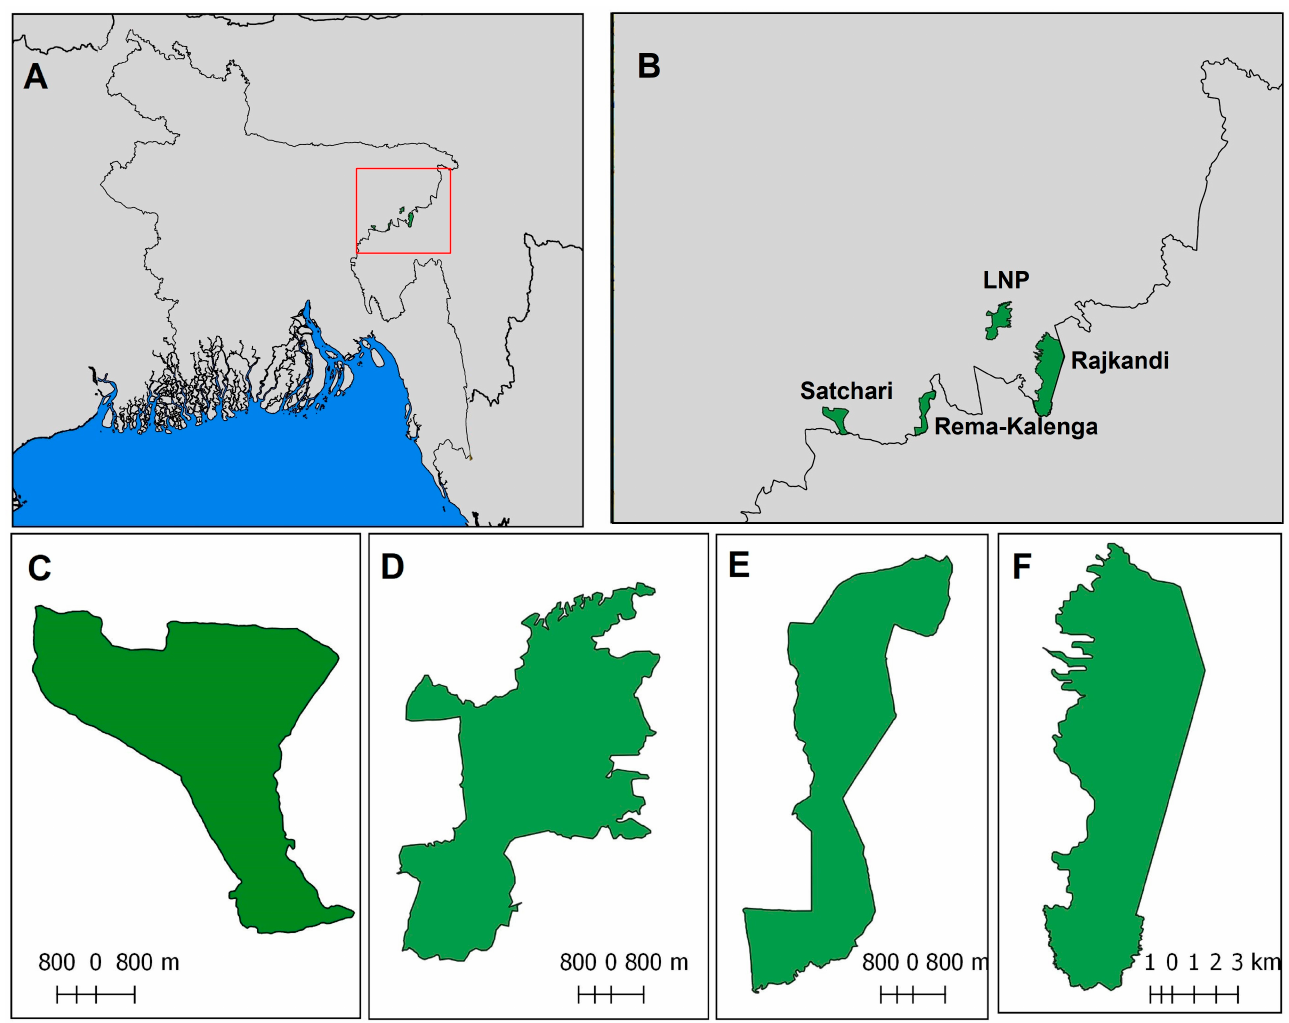
Figure 1. Map of Bangladesh; ( A , B ) The red square shows the area of the study sites in Bangladesh, whilst the small green patches show the position of the study sites in Bangladesh, and the size of the study sights is represented in ( C ) Satchari, ( D ) Lawachara National Park, ( E ) Rema-kalenga, and ( F ) Rajkandi.